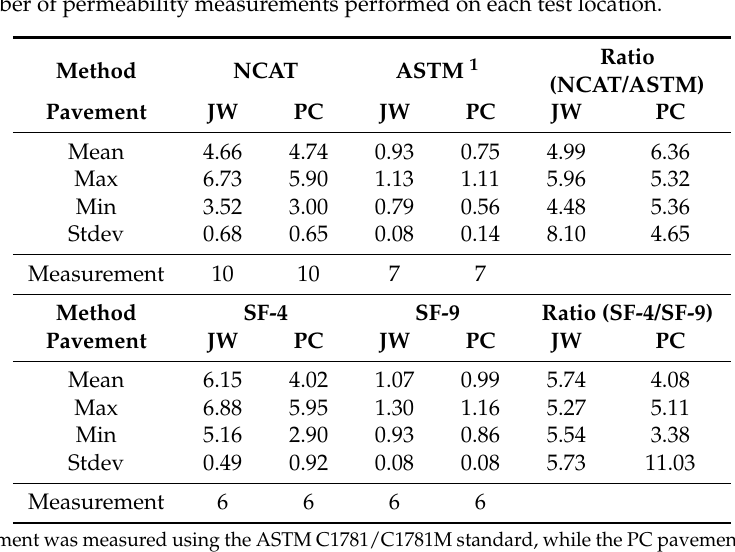
Table 1. Mean permeability (cm/s) of JW pavement and pervious concrete (PC) pavement measured on six different locations with NCAT (falling head principle), ASTM (constant head principle), square frames SF-4 (falling head principle) and square frame SF-9 (constant head principle). The measurement was the number of permeability measurements performed on each test